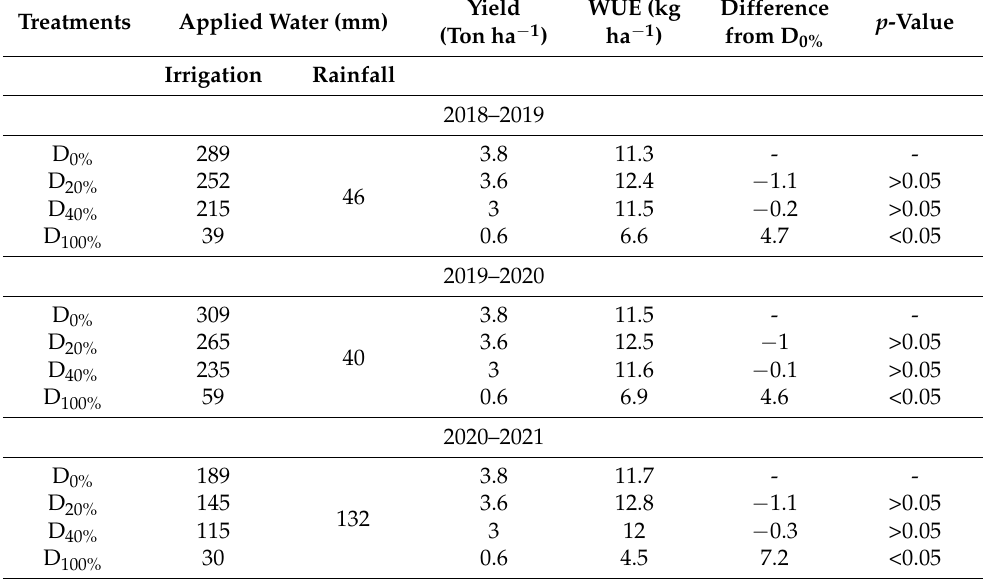
Table 5. Amount of water applied, yield, and water use efficiency with different irrigation treatments during growing season of